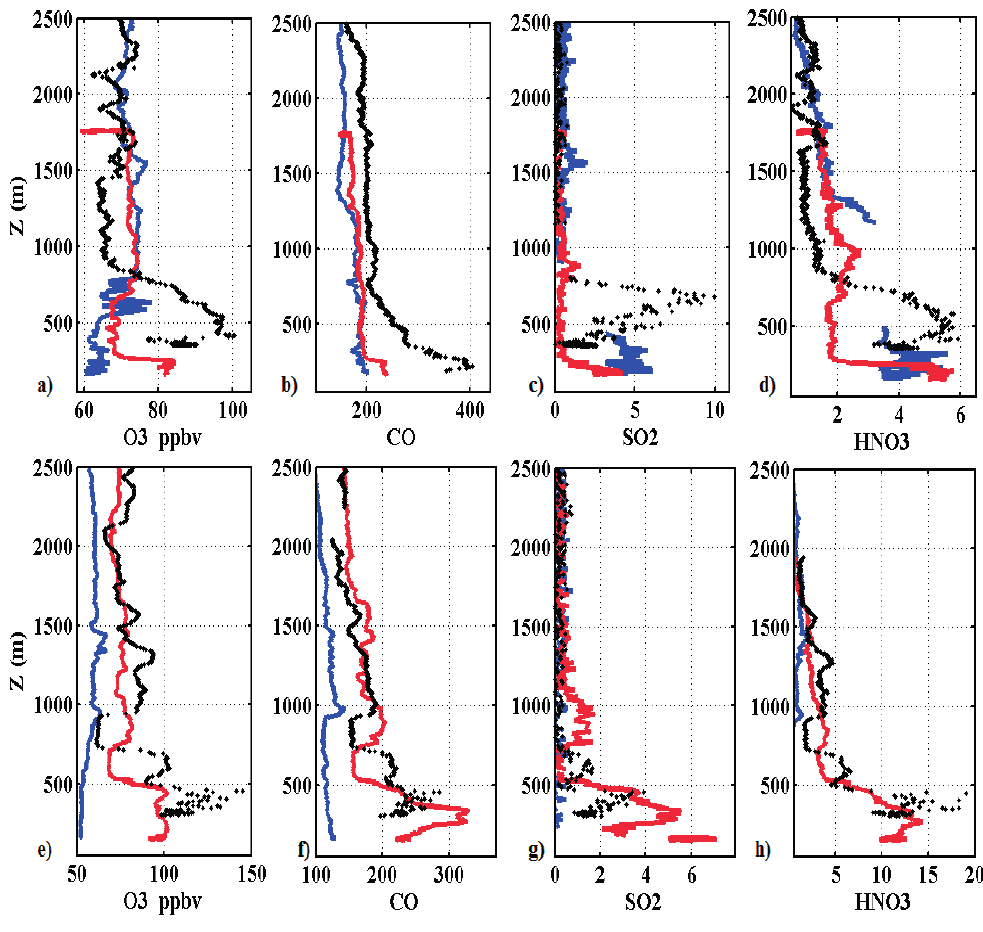
Figure 6. Aircraft profiles over the coastal GOM of ( a ) O3; ( b ) CO; ( c ) SO2 and ( d ) HNO3; Corresponding observations of the same trace gas species over the western Atlantic/eastern GOM are shown in ( e – h ). Blue lines represent observations on 7/20, red 7/21 and black 7/22 with all trace gas observations measured in in